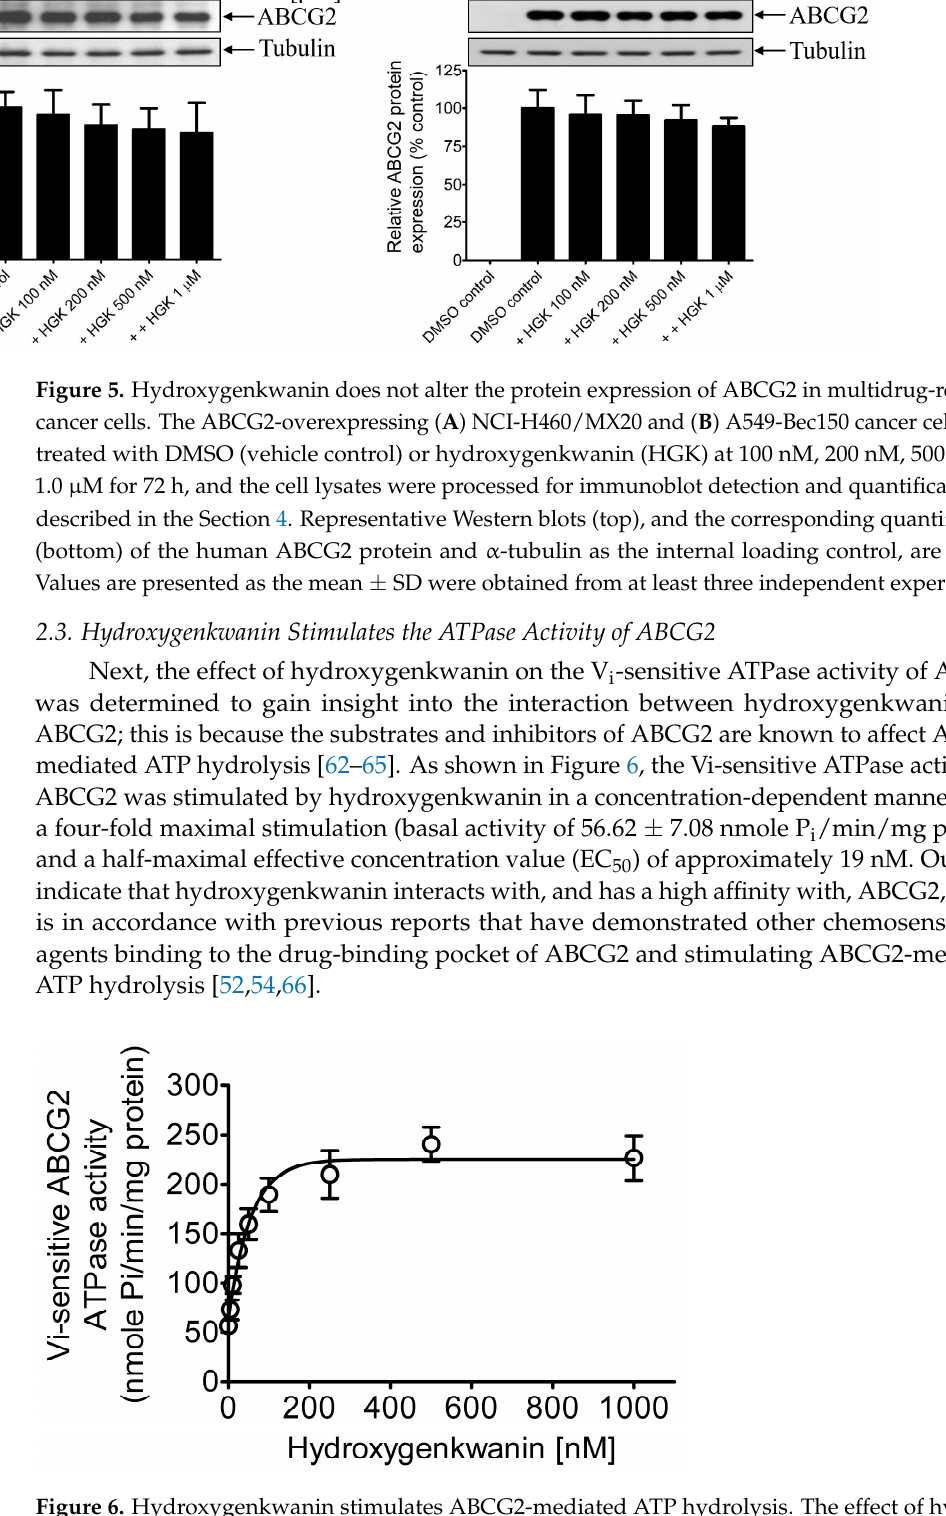
Figure 6. Hydroxygenkwanin stimulates ABCG2-mediated ATP hydrolysis. The effect of hydrox- ygenkwanin (0–1 μ M) on the vanadate (Vi)-sensitive ATPase activity of ABCG2 was determined by endpoint P i liberation assays using membrane vesicles prepared from ABCG2 baculovirus-infected High-Five insect cells, as previously described [65]. Points, mean from at least three independent experiments; bars,